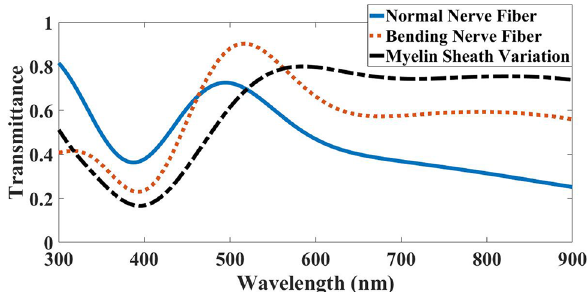
Figure 13. Light transmission spectra in the case of light launched to the myelin sheath in three modes of normal myelinated axons, bending nerve fiber and myelin sheath variation.